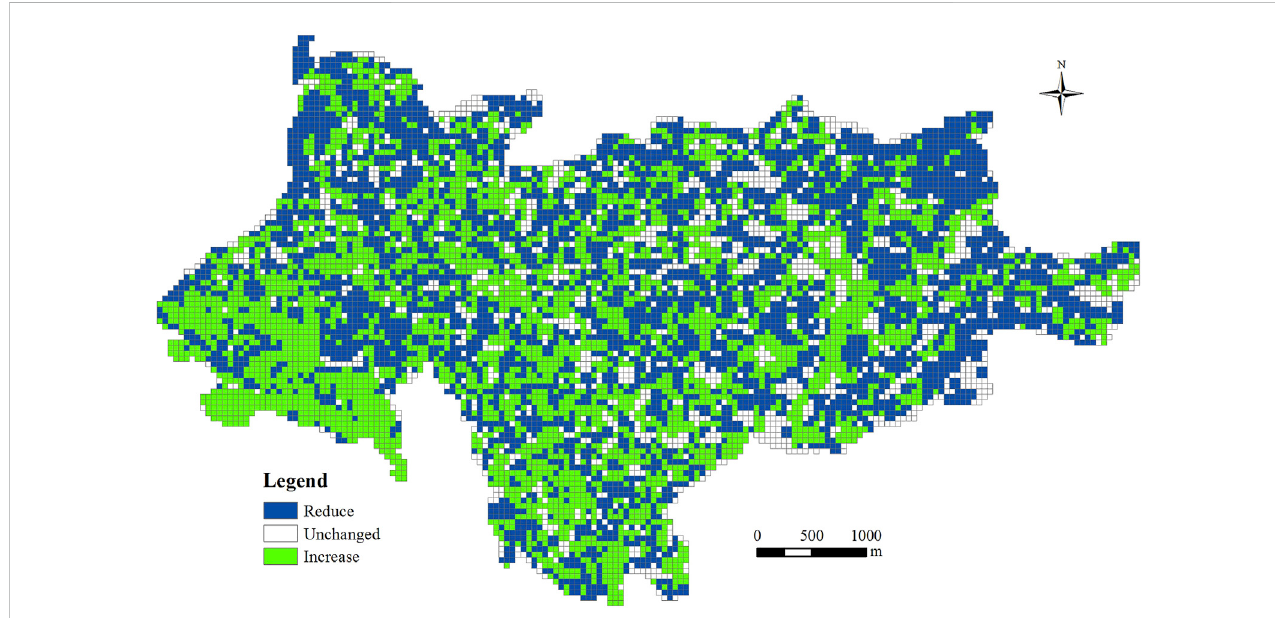
FIGURE 4 Changes in the value of ecosystem services, 2015 –